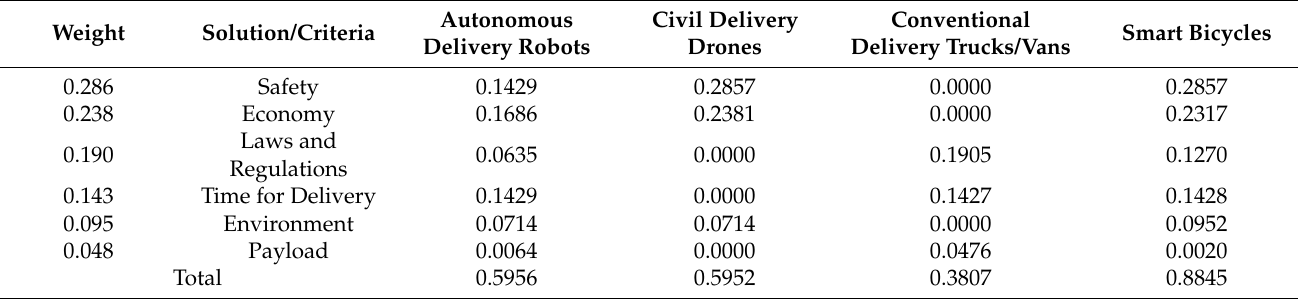
Table 13. Total scores, rank sum method—in the case of S2.